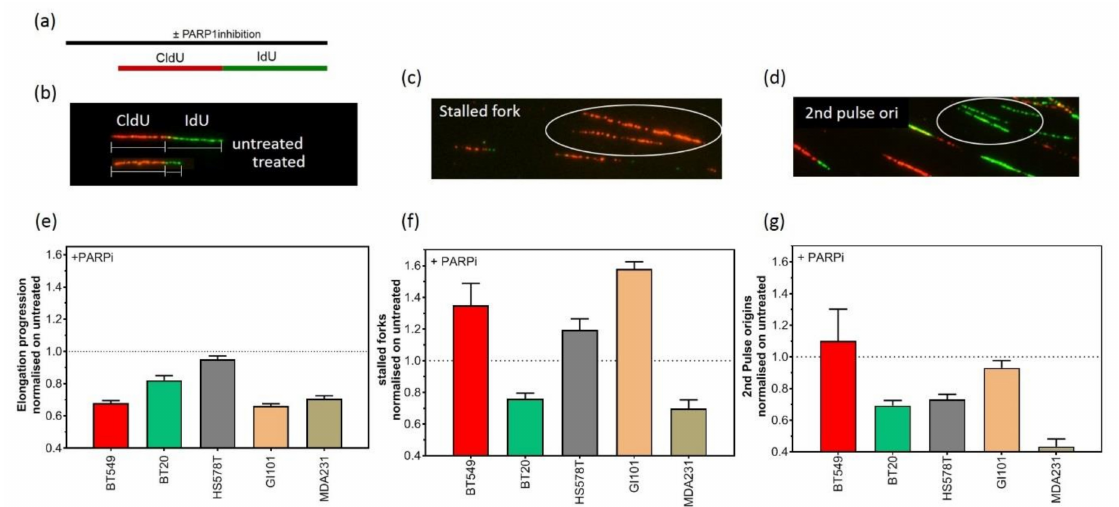
Figure 3. Replication fork elongation, stalling and new origin firing after PARP1 inhibition. ( a ) Overview of DNA fiber assay labelling protocol. Representative picture of reduced IdU-fiber length after treatment, in comparison to full-length IdU fiber in untreated sample ( b ), of CldU labelled, IdU-negative fiber indicating stalled replication fork ( c ) and representative picture of IdU labelled, CldU negative fiber, indicating second pulse origin firing ( d ). Quantitative analysis of elongation tract length ( e ), replication fork stalling ( f ) and second pulse origin firing ( g ) after PARP1 inhibition normalized on untreated controls. Each value represents the mean of at least three independent experiments with SEM